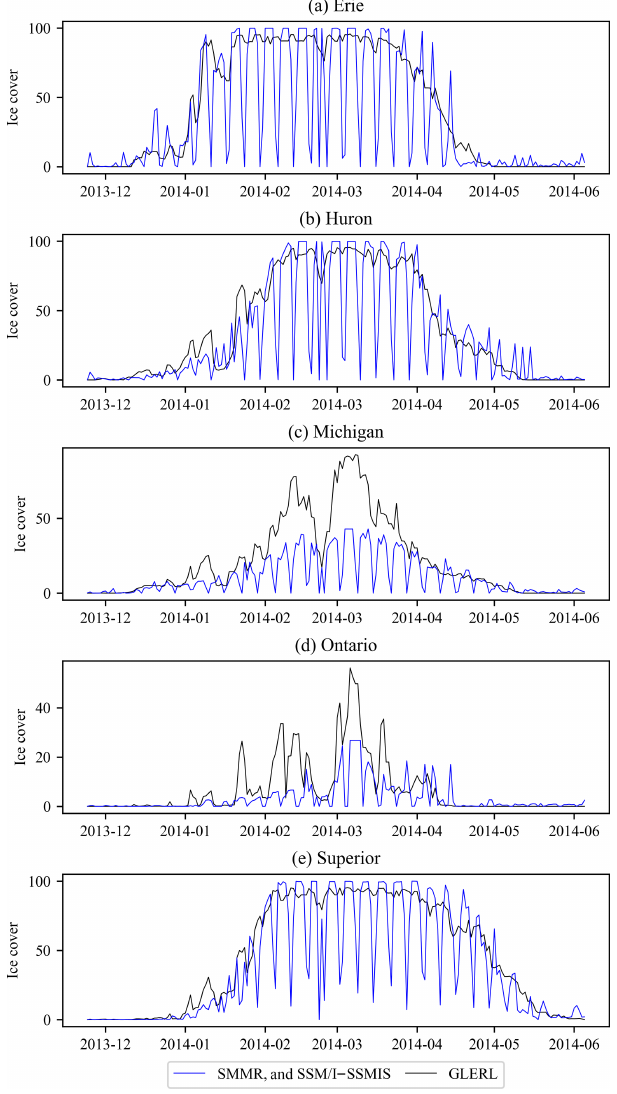
Figure 7. Comparisons of the annual maximum ice cover (percent- age of lake area) of the Great Lakes from the GLERL records and SMMR and SSM/I–SSMIS data: (a) Superior, (b) Huron, (c) Michi- gan, (d) Erie, and (e) Ontario.